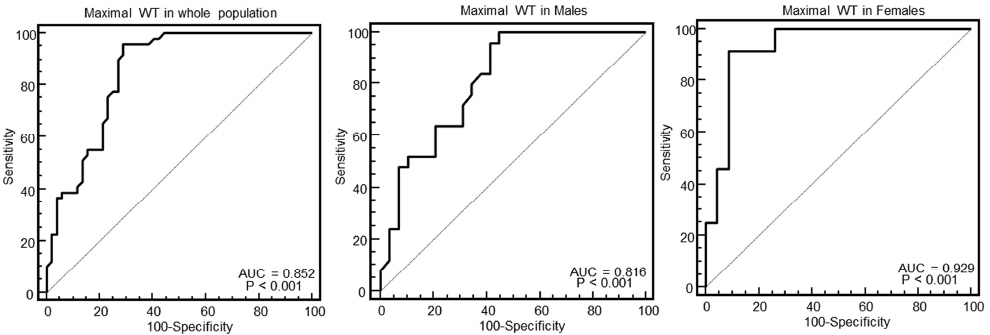
Figure 4. Receiver operating characteristic curves of the maximal wall thickness (WT) for identification of patients with HCM in the whole population, and in males and females.